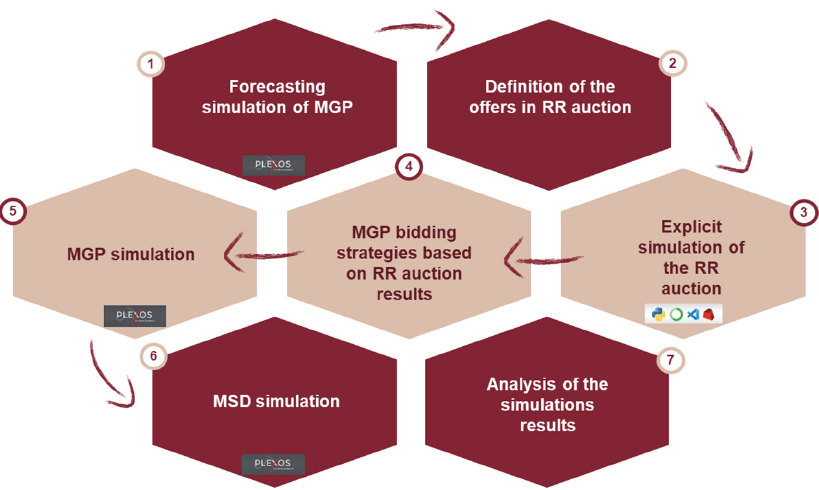
Figure 1. Simulation chain.